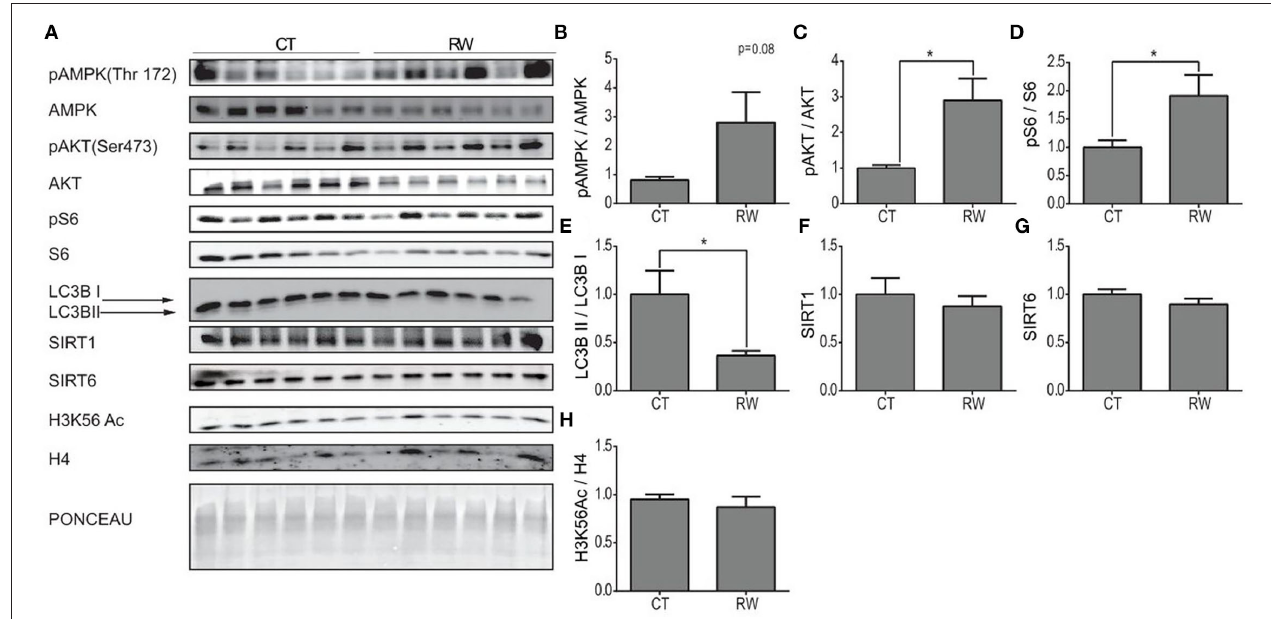
FIGURE 4 | Unique hippocampal AMPK and AKT signaling pathway activation under voluntary exercise. (A) Western blot analysis of pAMPK, AMPK, pAKT, AKT, pS6, S6, LC3B, SIRT1, SIRT6, and H3K56Ac, in the hippocampi of young (4–6 months) WT male mice, at rest (CT) or under long-term voluntary exercise (RW). Ponceau staining served as loading control. (B) Phosphorylated AMPK to unphosphorylated AMPK ratio (C) phosphorylated AKT to unphosphorylated AKT ratio. (D) Phosphorylated S6 normalized to unphosphorylated S6; (E) LC3B II protein expression normalized to LC3B I protein expression. (F) SIRT1 and (G) SIRT6 protein expression levels normalized to actin. (H) H3K56Ac normalized to H4. The values shown are mean ± s.e.m., * p < 0.05 (two-tailed t -test); in (A–H) n = 6 for CT and